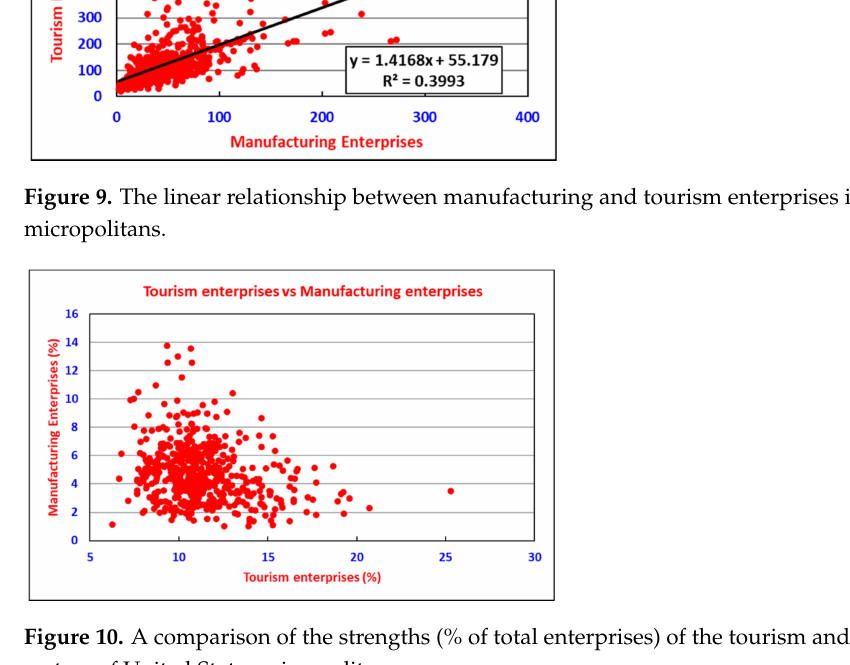
Figure 10. A comparison of the strengths (% of total enterprises) of the tourism and manufacturing sectors of United States micropolitans.